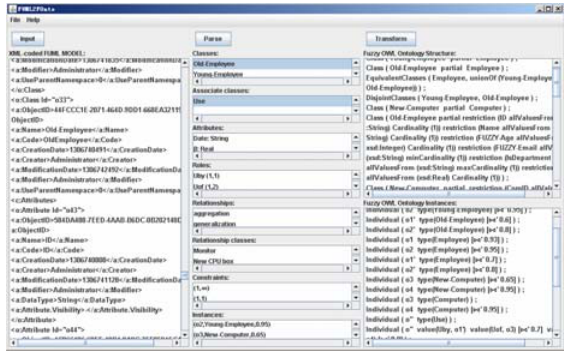
Fig. 12. Screen snapshot of FUML2FOnto